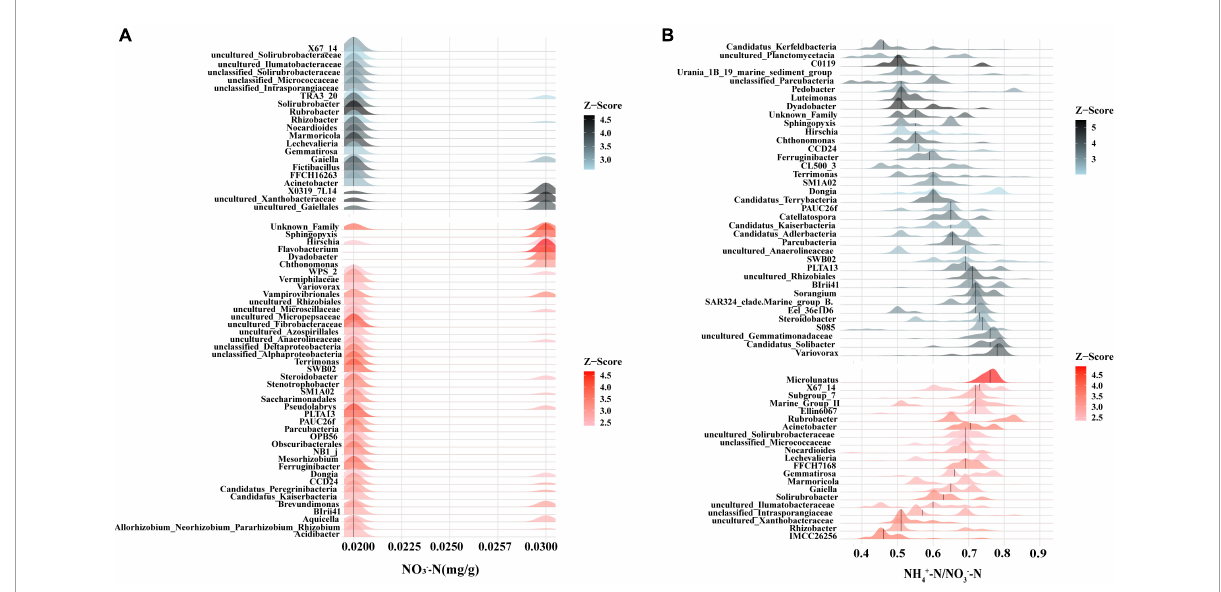
FIGURE6 Threshold indicator taxa analysis (TITAN) on the response of bacteria genus to NO 3 − -N content (A) and the ratio of NH 4 + -N/NO 3 − -N (B) . Red color represents positive response (i.e., abundance increases), black color represents negative response (i.e., abundance